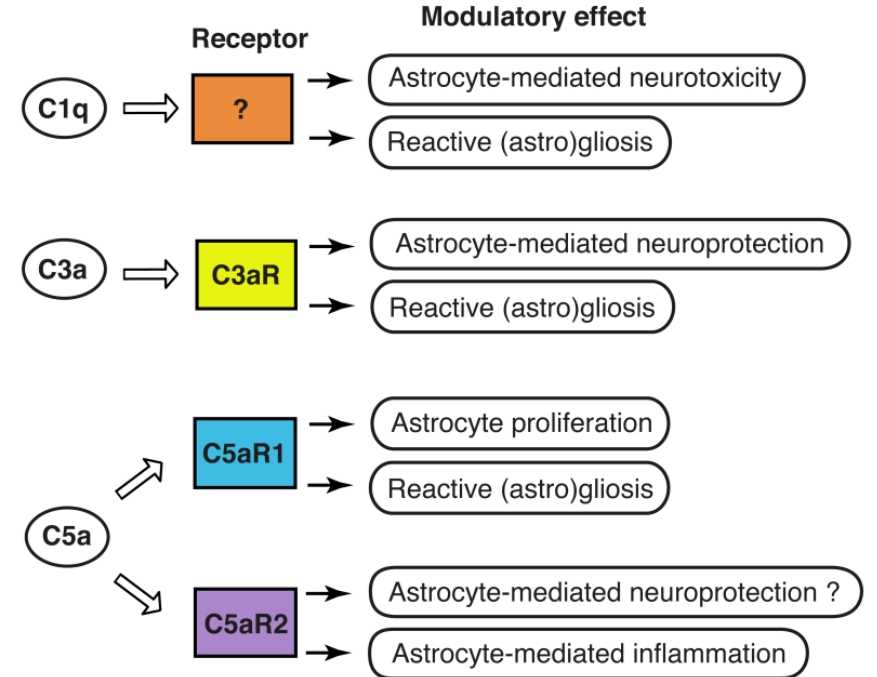
Figure 2. Complement is a modulator of astrocyte function: known and putative effects of the complement components C1q, C3 and C5 on astrocytes. While there are several potential candidates, the specific receptor through which C1q exerts its modulatory effects on astrocytes is currently unknown. C3a and C5a exert their modulatory effects through C3aR, C5aR1 and